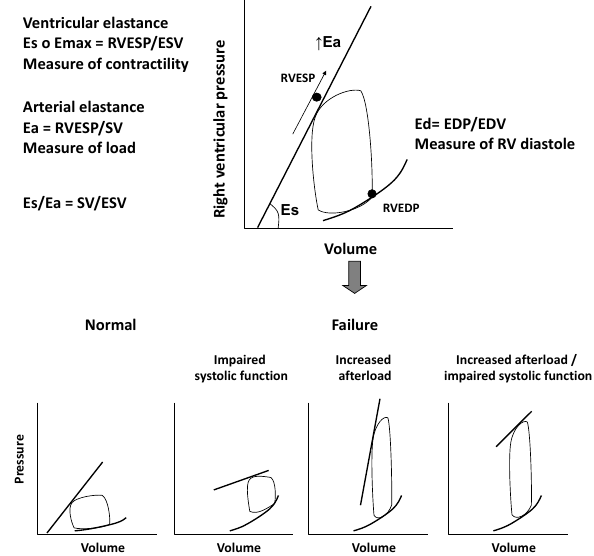
Figure 1. Figure shows the relation between right ventricle contractility, preload, and afterload through pressure / volume loops. In the lower part of the figure, pressure / volume loops in condition of different loading conditions and right ventricle dysfunction are displayed. Eas: End-systolic elastance; Emax: maximal elastance; RVESP: right ventricle end-systolic pressure; ESV: end-systolic volume; Ea: arteralelastance; SV: stroke volume; Ead; End-diastolic elastance; EDP; end-diastolic pressure; EDV: end-diastolic volume.